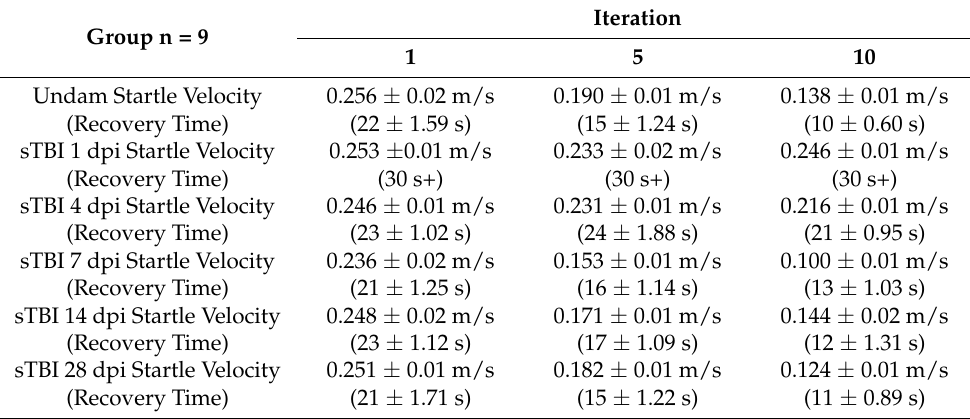
Table 2. Blunt-force TBI induces non-associative learning impairments that rapidly recover. Quantifi- cation of initial swim velocities and recovery time following startle onset of undamaged and sTBI fish that were evaluated for startle response at iterations 1, 5, and 10 of the startle stimulus across multiple dpi (n = 9). Group n =